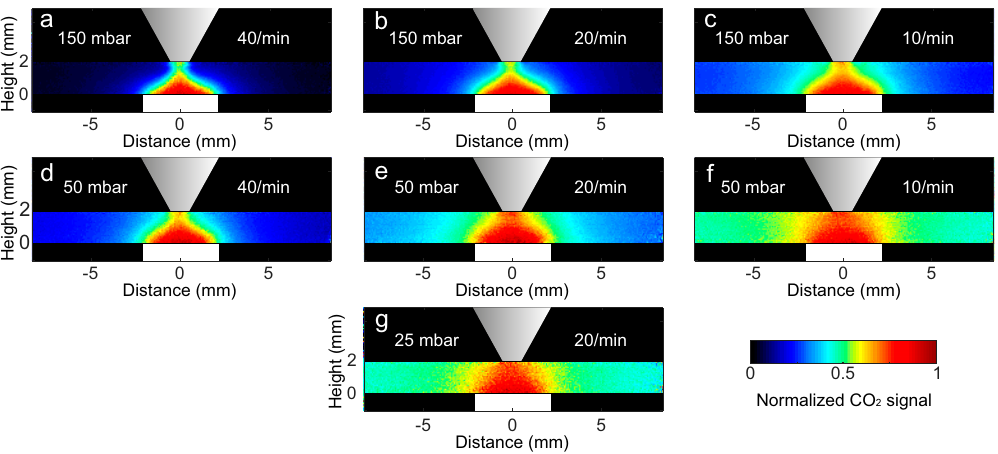
Figure 3. Pressure and flow dependence of the CO 2 distribution over a Pd(100) single ‐ crystal catalyst in the mass transfer limited (MTL) regime: ( a – c ) chamber pressure at 150 mbar, gas exchange rate at 40, 20 and 10 per minute, respectively; ( d – f ) chamber pressure at 50 mbar, gas exchange rate at 40, 20 and 10 per minute, respectively; ( g ) chamber pressure at 25 mbar, gas exchange rate at 20 per minute. All PLIF images are 1000 laser ‐ shot averaged (acquisition time of 100 s). The nozzle is used as the gas outlet, which is connected to a vacuum pump and a mass spectrometer.